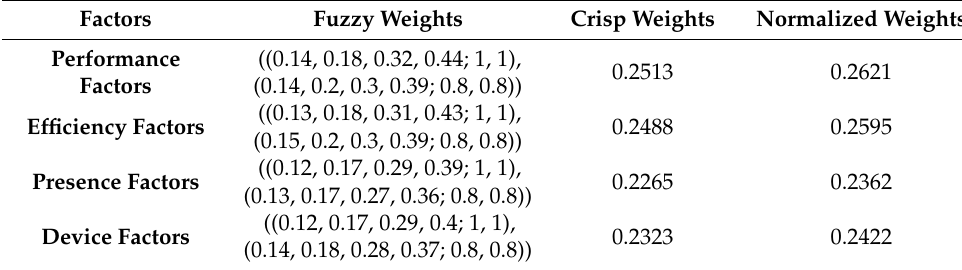
Table 7. Local weights of Evaluation